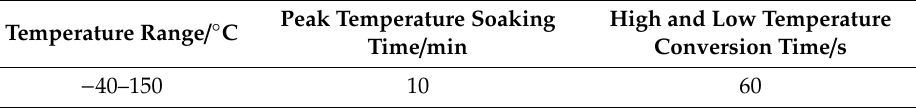
Table 2. Thermal shock test